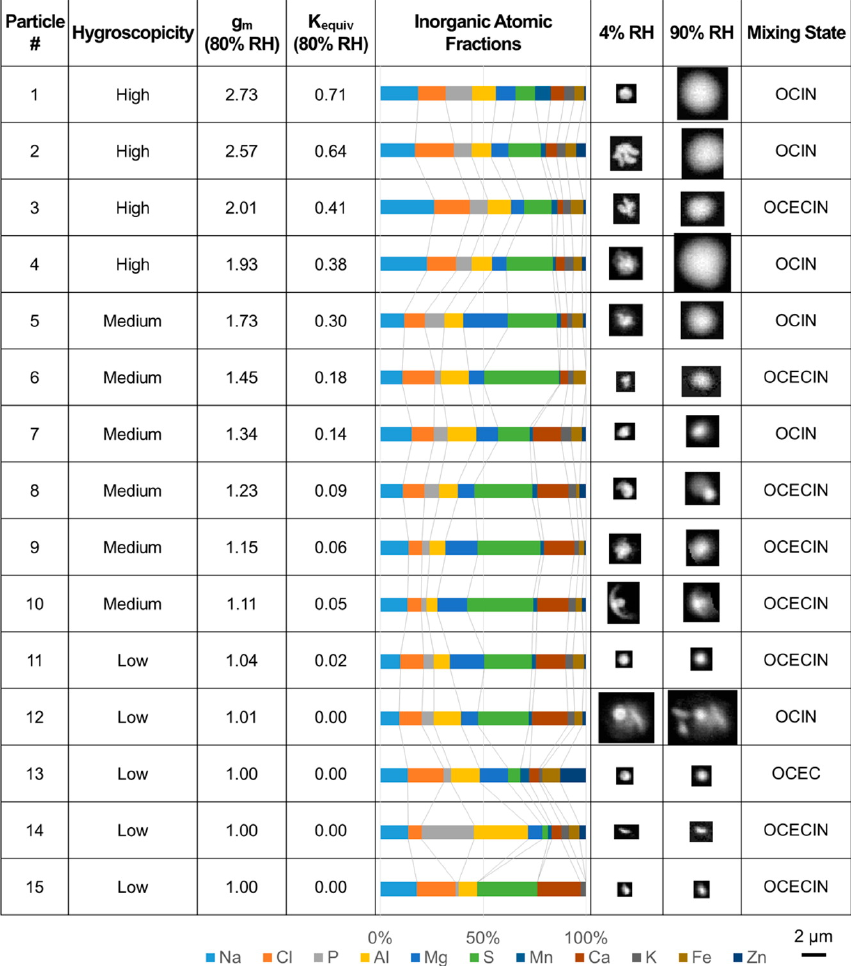
Figure 11. Hygroscopicity, mass growth factors at 80% RH ( g m ), single hygroscopicity parameters ( κ eqiv ), inorganic atomic fractions, STXM images (acquired at 4% RH and 90% RH) and mixing state for the 15 aerosol particles examined. Reprint with permission by Piens et al. (2016). Copyright 2016 American Chemical